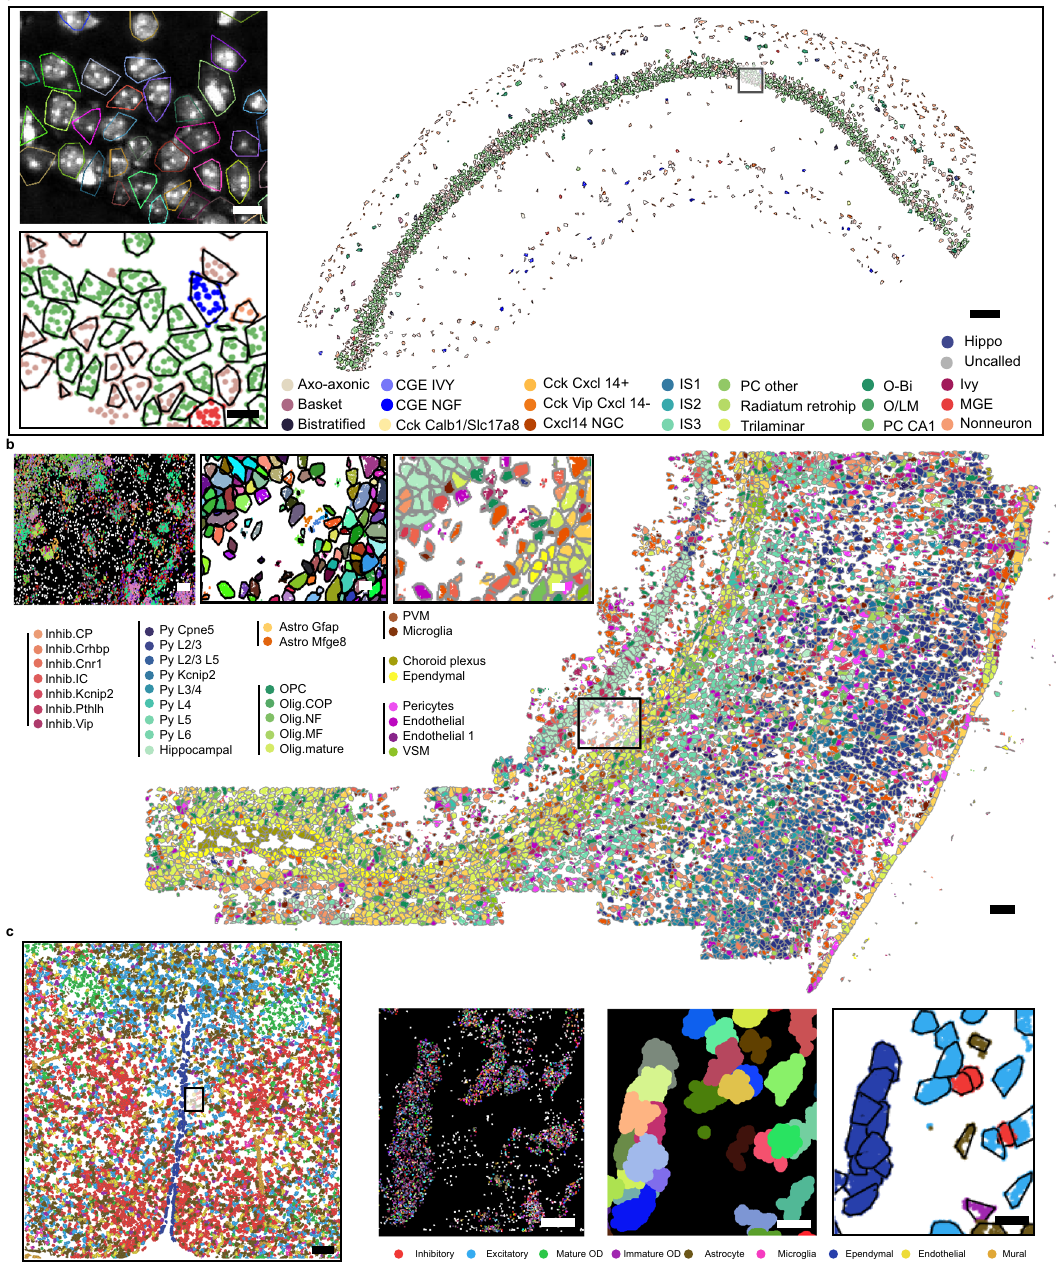
Fig. 5 ClusterMap across different spatial transcriptomics methods. a Cell type map of the pciSeq (ISS data) section 4 – 3 left CA1 dataset 4 . Scale bar: 200 µ m. Insets from top to bottom: convex hull of ClusterMap-identi fi ed cells overlapped with the DAPI image and zoom-in cell type map in the black box highlighted region. Scale bar: 10 µ m. b Cell type map of whole osmFISH mouse SSp datasets 5 . Scale bar: 100 µ m. Insets from left to right: raw spatial transcriptomics data, and corresponding cell segmentation map and cell type map of the black box highlighted region. Scale bar: 10 µ m. c The 2D cell type map of whole MERFISH mouse POA datasets 3 . Scale bar: 200 µ m. Insets from left to right insets: 2D raw spatial transcriptomics data, and corresponding cell segmentation map and cell type map of the highlighted region. Scale bar: 10 µ